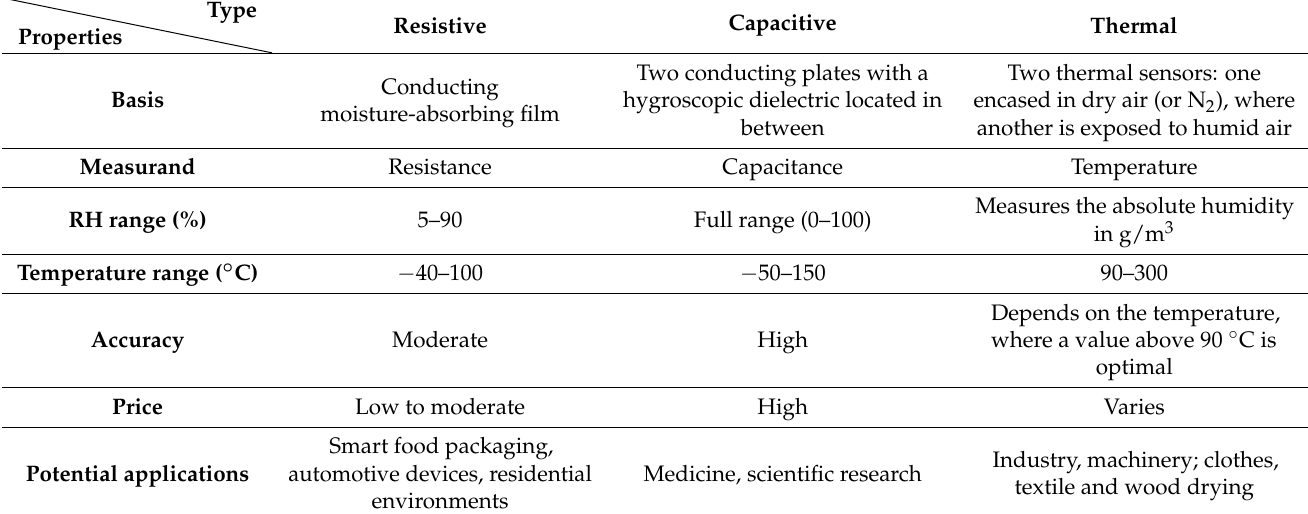
Table 1. Common humidity sensor types: resistive, capacitive, and thermal